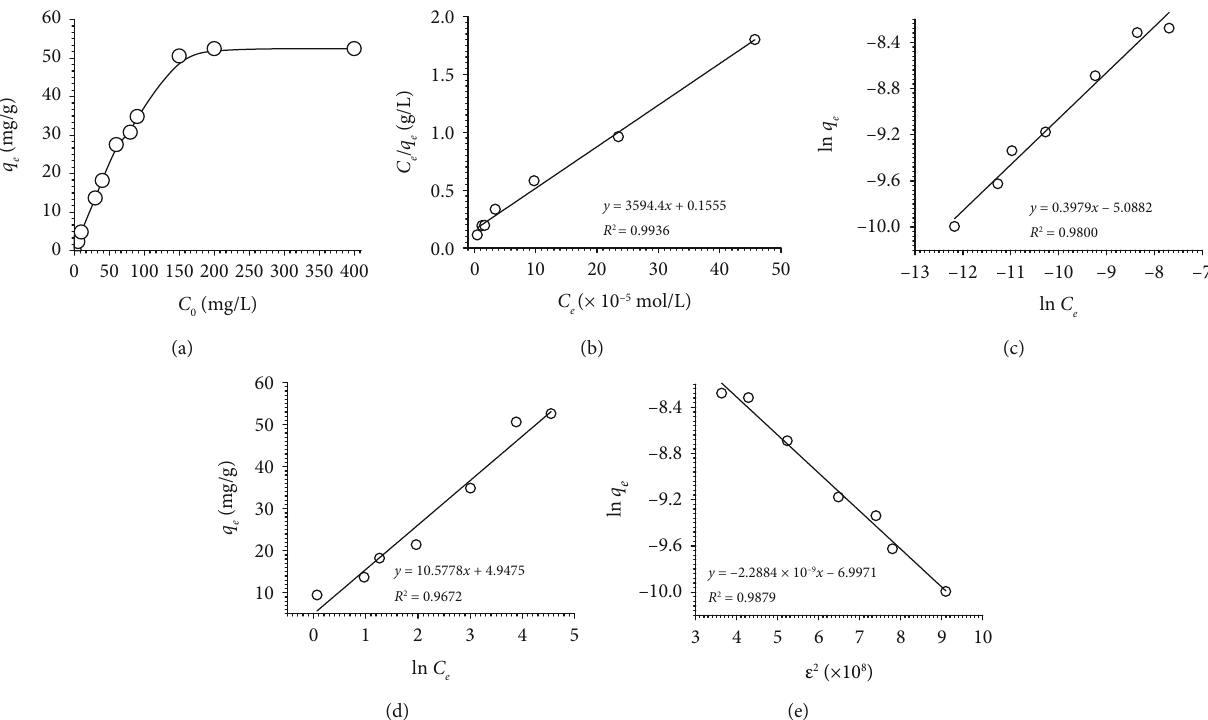
Figure 6: (a) The removal uptake of Pb(II) as the function of initial concentration ( C (d) Temkin, and (e) D-R isotherm models of Pb(II) sorption onto